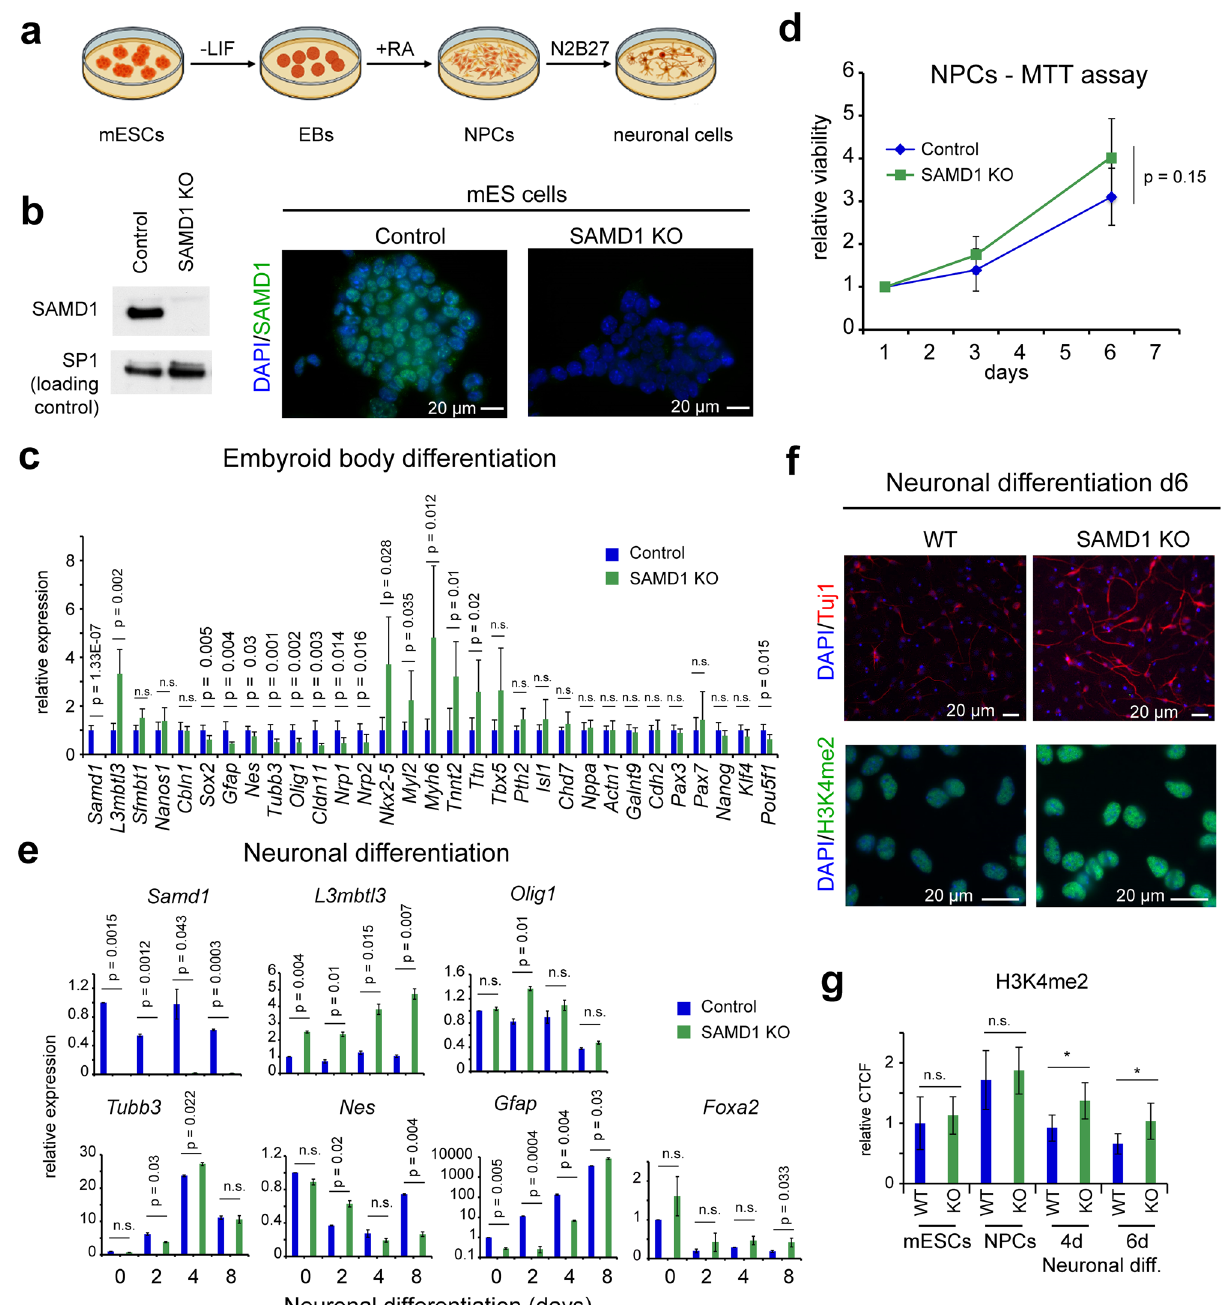
Figure 7. SAMD1 KO affects neuronal differentiation in vitro. ( a ) Schematic steps of the neuronal differentiation procedure. The graphic was created on BioRender.com. ( b ) Representative immunofluorescence and Western blots of wild-type (Control) and SAMD1 KO ES cells, which were established previously 4 . Full Westerns blots are shown in Supplementary Fig. S6. ( c ) RT-qPCR of differentiation-related genes after embryoid body formation. Data are presented as the mean ± SD of two biological replicates. ( d ) MTT assay of neuronal progenitor cells. Data are presented as the mean ± SD of three biological replicates. ( e ) RT-qPCR of marker genes upon neuronal differentiation, starting from NPCs. Data are presented as mean ± SD of two biological replicates. ( f ) Representative immunofluorescence for Tuj1 (Tubb3) and H3K4me2 in differentiated neuronal cells. ( g ) Quantification of H3K4me2 levels at distinct stages during the neuronal differentiation procedure. CTCF = corrected total cell fluorescence. Data are presented as mean ± SD of at least 15 cells per condition. Significance in ( c , d , e , g ) was evaluated via a two-tailed unpaired Student’s t-test. n.s. not